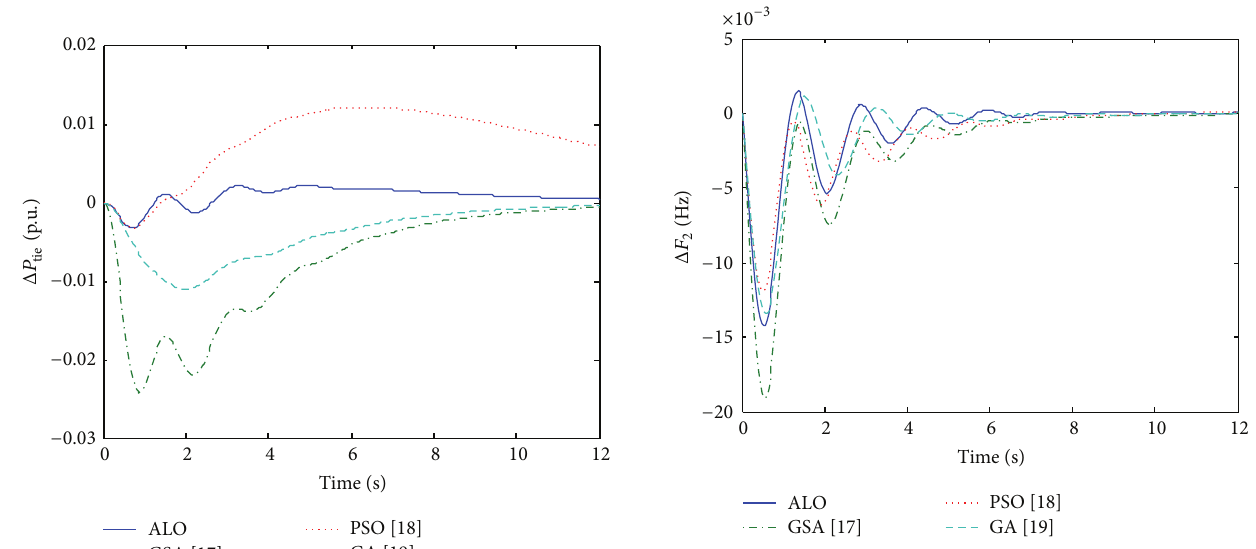
Figure 11: Change in frequency of area 2 by 25% load increase in area